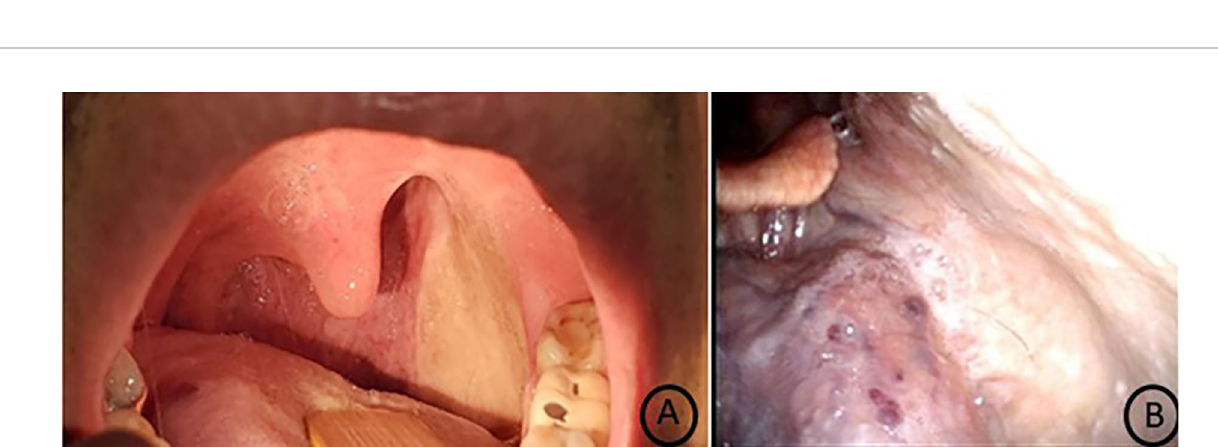
FIGURE 2 | Reexamination 1 year after surgery. (A) The reconstructive submental island fl ap has coalesced with surrounding normal mucosa. (B) The pharyngeal wall reconstructed by the submental island fl ap healed well and had a natural